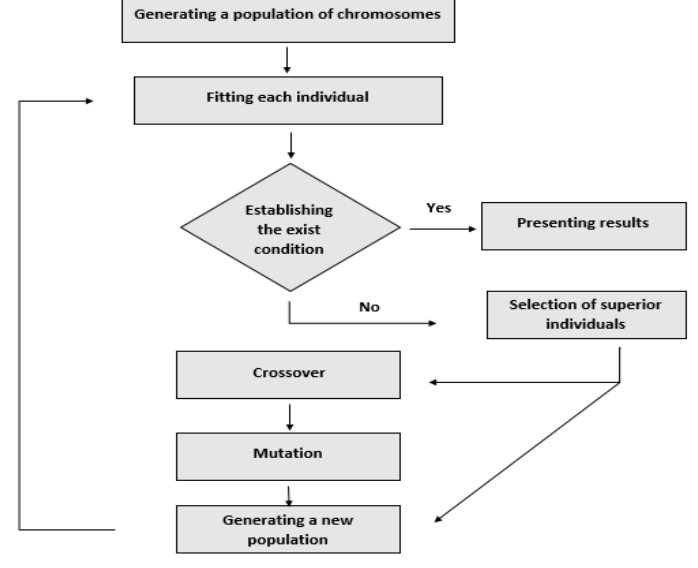
Figure 2. The schema of different stages of the Genetic